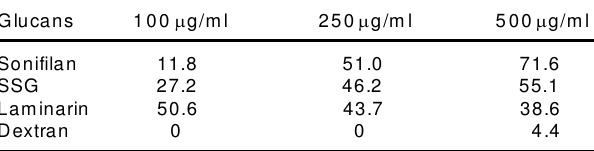
Table 2. Inhibitory effect (%) of b -glucans on tumor necrosis fac- tor- a production induced with grifolan. RAW264.7 cells were cul- tured with a mixture of grifolan and the glucans